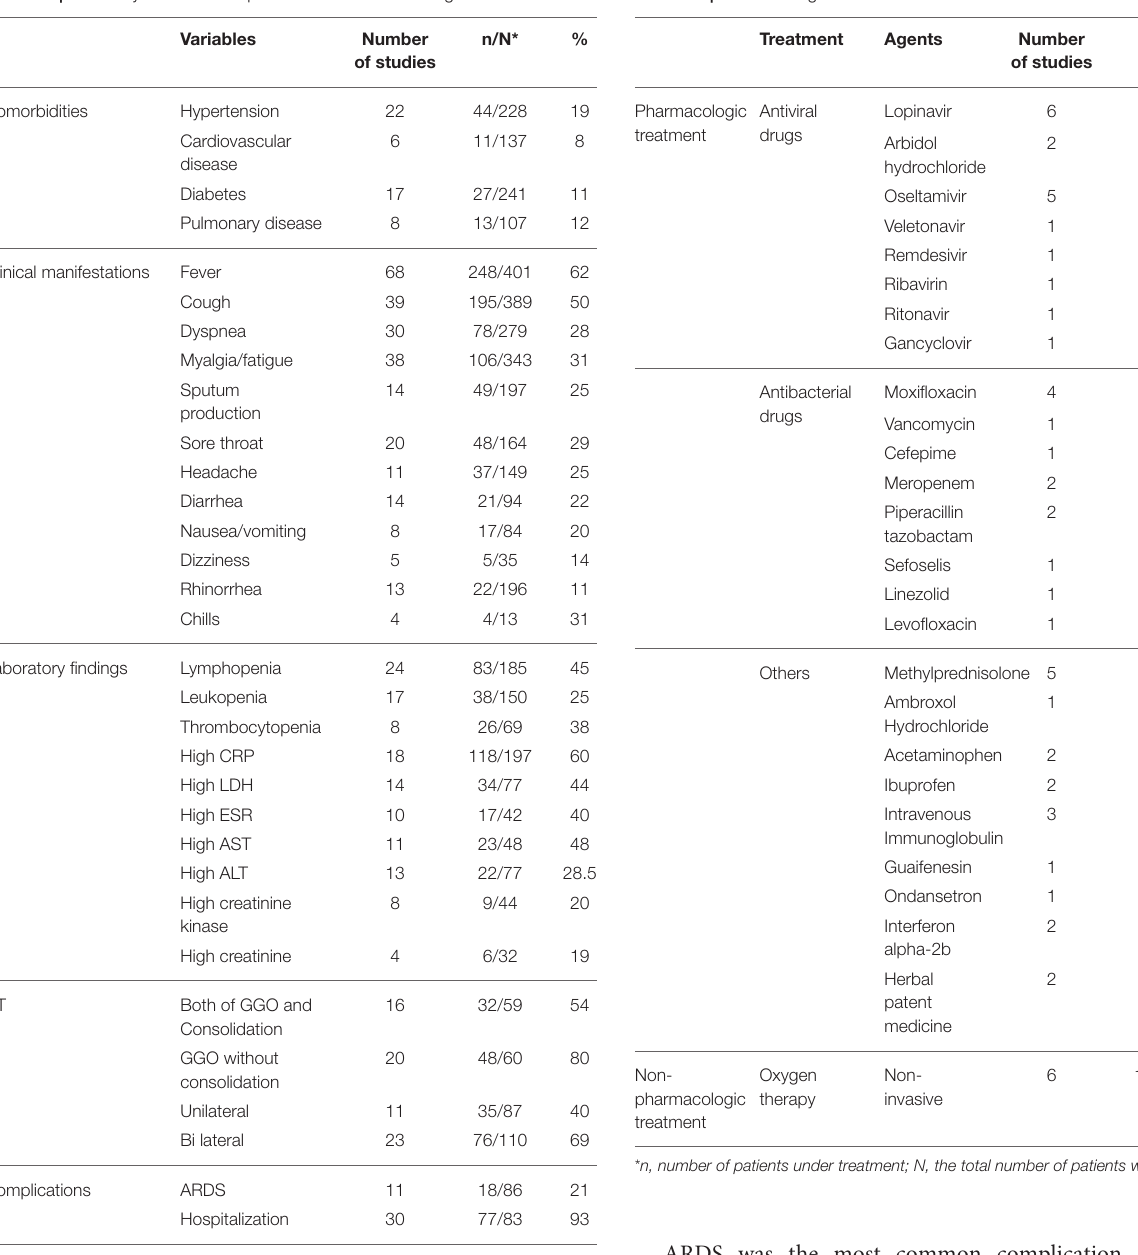
TABLE 3 | Treatment agents used in the included